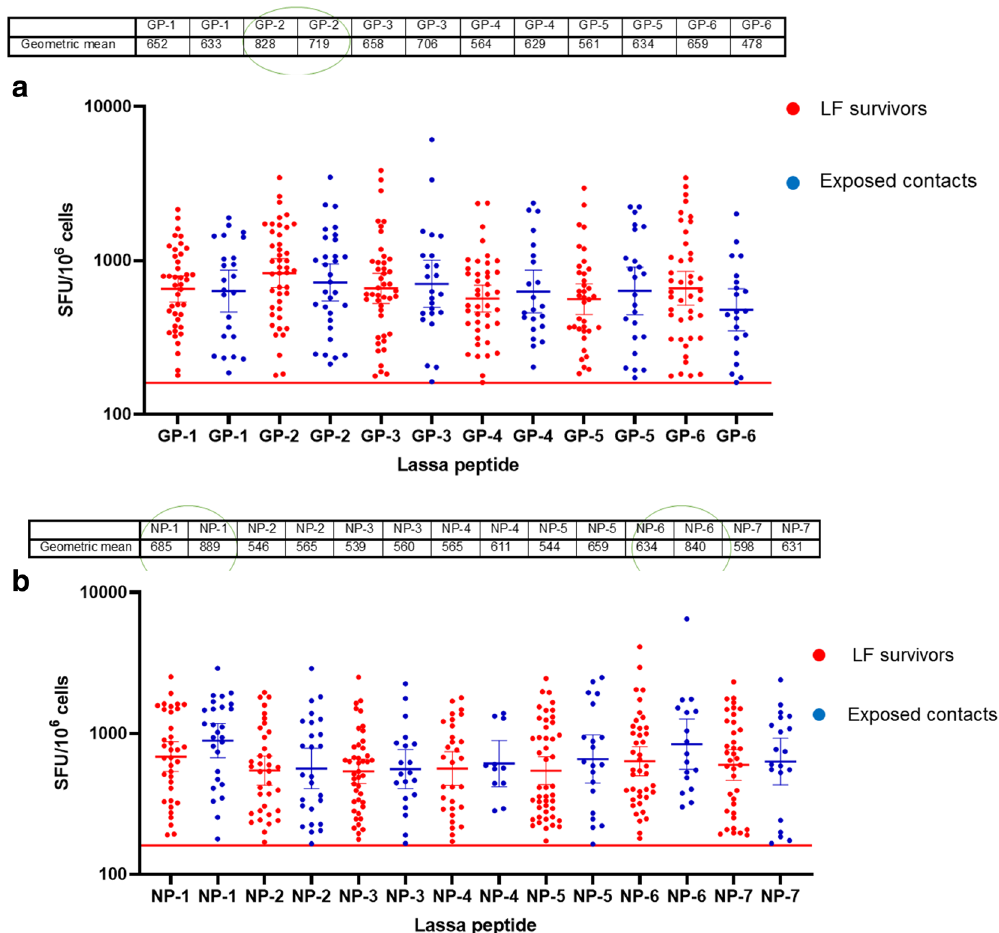
Figure 1. T cell response to LASV GP ( a ) and NP ( b ) proteins from LF survivors and their contacts in Southern Nigeria. PBMCs from either LF survivors (N = 92) or their contacts (N = 50) were stimulated with computationally selected Lassa GP and NP peptides. Interferon gamma ELISpots measured in spot forming units (SFU) per 1.0 × 10 6 PBMC was used as a read out for T cell response. The result (table showing geometric mean at 95% CI) showed similar T cell response to both GP ( a ) and NP ( b ) peptides from both LF survivors and their contacts. The highest frequency of T cell response was seen in the GP 2 region and NP 1 and 6 regions (green circle). The average limit of detection (red line = 160) was calculated as the mean multiplied by three standard deviations of the three known negative samples.